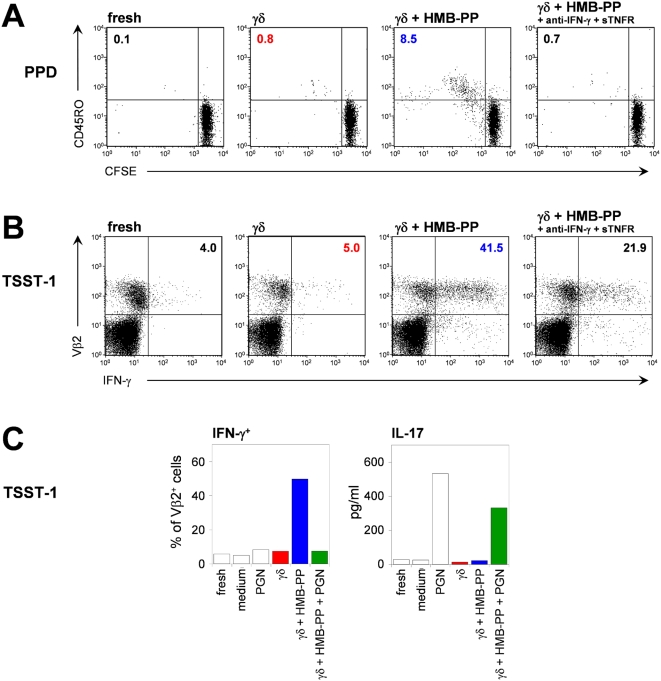
Vγ9/Vδ2 T cell-activated monocytes present bacterial antigens to autologous αβ T cells.(A) Freshly isolated monocytes, or activated monocytes generated for 18 hours under the conditions indicated were used as APCs and incubated with CFSE-labeled naïve αβ T cells in the presence of PPD. CFSE dilution and CD45RO expression was measured after a further 96 hours of culture. Dot plots are gated on total CD3+ T cells; numbers indicate the percentage of CFSElo CD45RO+ T cells. (B) Freshly isolated monocytes, or activated monocytes generated as above were loaded with TSST-1 and used as APCs for αβ T cells. Intracellular cytokine expression in responder T cells was measured after 72 hours of culture. Dot plots are gated on total CD3+ T cells; numbers indicate the percentage of Vβ2+ T cells expressing IFN-γ. No cytokine expression occurred in the absence of TSST-1. (C) IFN-γ and IL-17 production by naive CD4+ T cell cultures in the presence of TSST-1-pulsed freshly isolated monocytes or monocytes pre-treated under the conditions indicated, as detected after 72 hours by intracellular staining for IFN-γ (gated on TCR-Vβ2+ T cells) and ELISA for IL-17. Data in A–C are representative of two experiments performed.